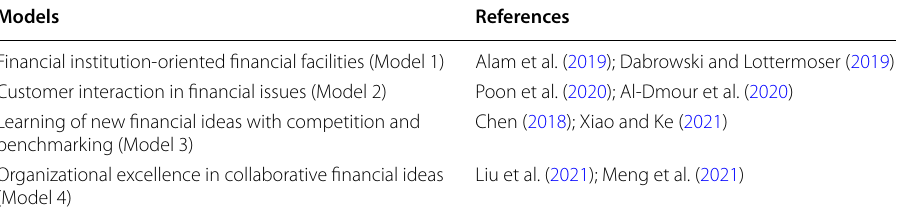
Table 7 Balanced scorecard-based open financial innovation models